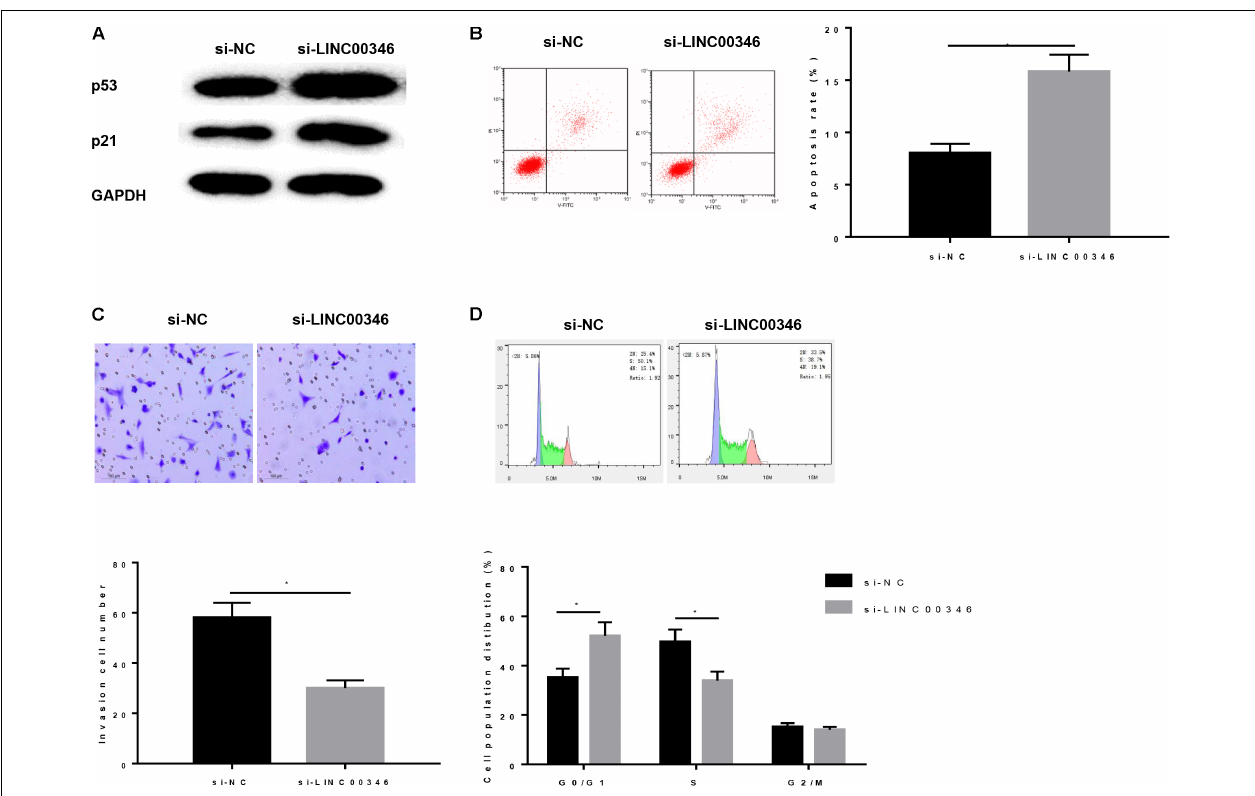
FIGURE 7 | Silencing LINC00346 affects the apoptosis, invasion and cell cycle of HCC. (A) Protein expressions of p53 and p21 in each group were detected by WB; Cells development in each group was detected by FCM and Transwell assays (100 × ). (B) Cell apoptosis; (C) Cell invasion; (D) Cell cycle. *represents P < 0.05.